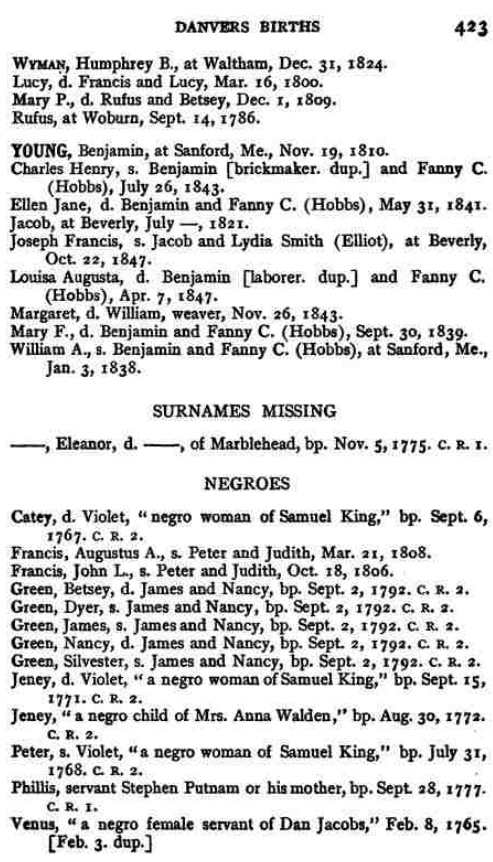
Figure 1. Scan from Massachusetts Vital Records , Danvers, “to the end of the year 1849,” with the birth records of Violet’s children. Vital Records page image for Danvers,